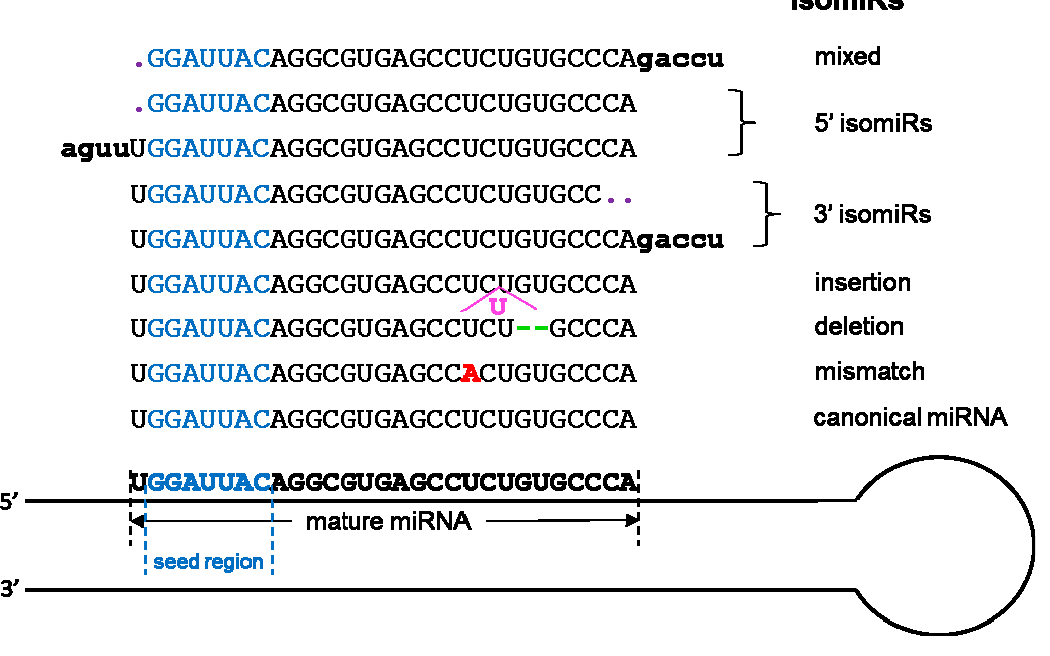
Figure 4. The most common scenarios for the formation of isomiRs. “Mixed” indicates that the formation of isomiRs can happen at both 3’ and 5’ ends. Table 4. Webservers for microRNA (miRNA) target